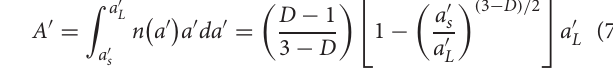
9.46 10 − 4 nm and (A) D = ×